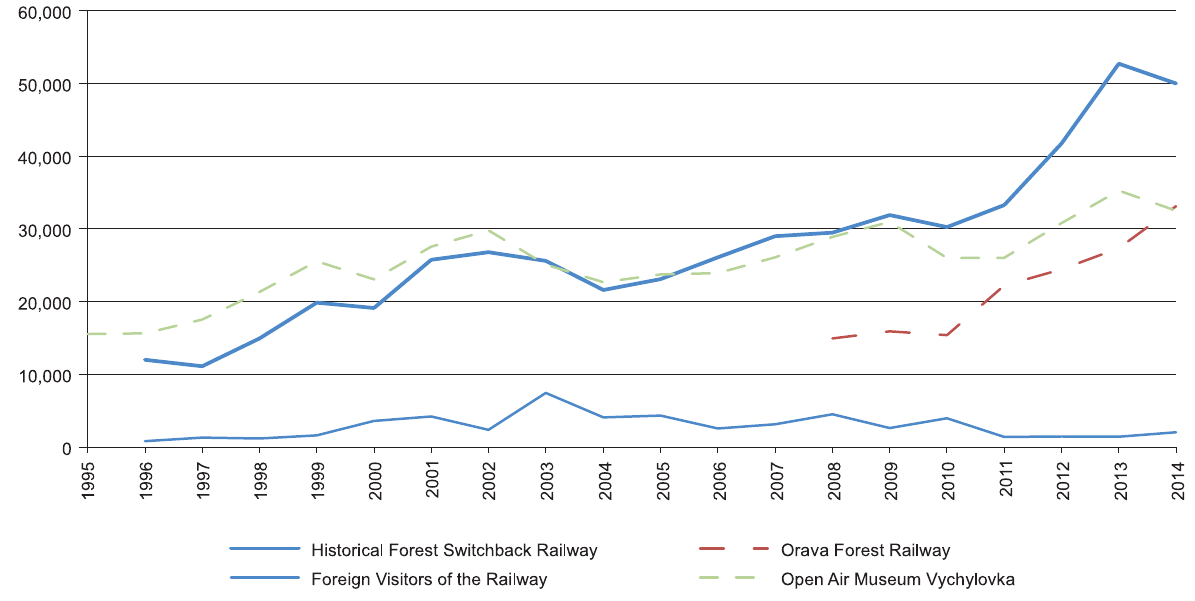
Fig. 11. Number of visitors on the Kysuce-Orava Forest Railway. Source: own elaboration based on data from the Kysuce